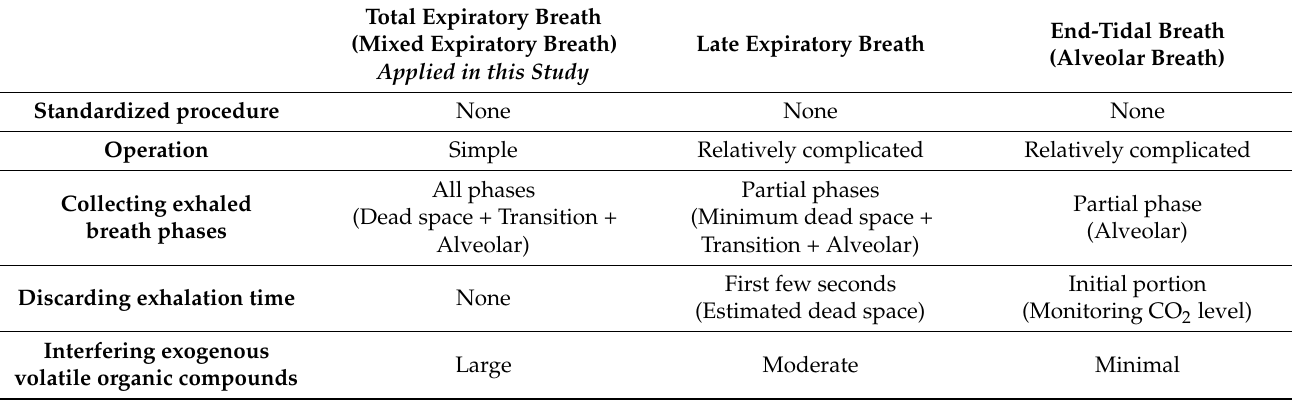
Table 1. Characteristics of the three methods for collecting exhaled breath